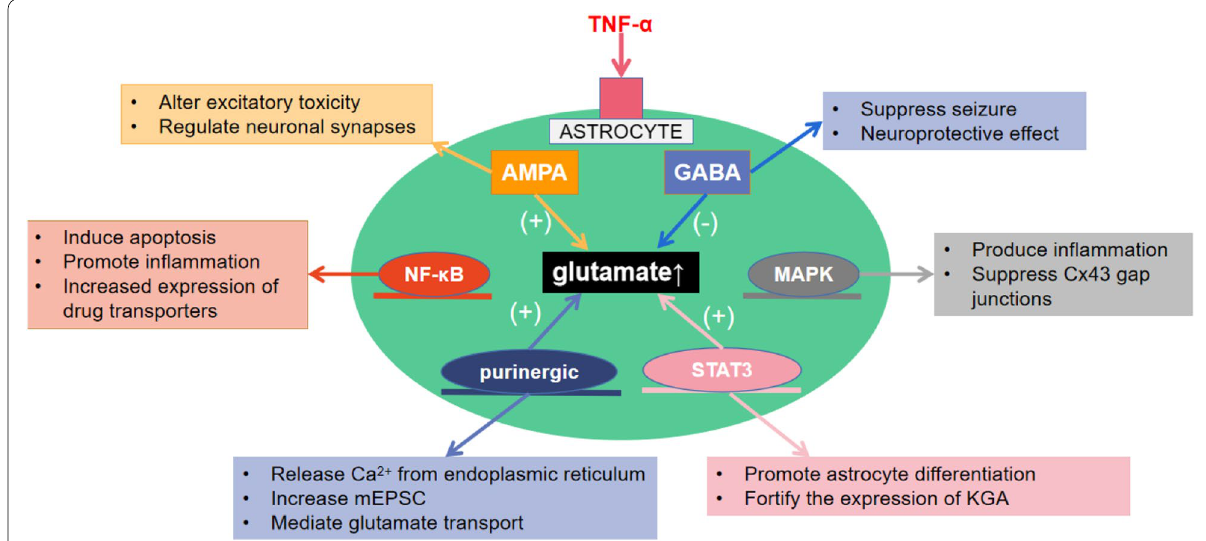
Fig. 1 The role of TNFα in different signaling pathways in astrocytes in epilepsy. Each signaling pathway produces different functions. Some may impair synaptic function, some boost cell apoptosis, and others raise production of glutamate. All of these will eventually promote